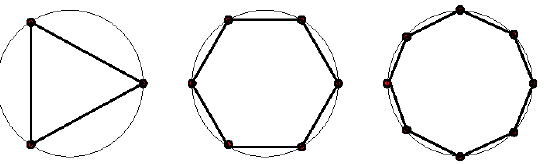
Figure 3. Approximation of circumference of unit circle using line